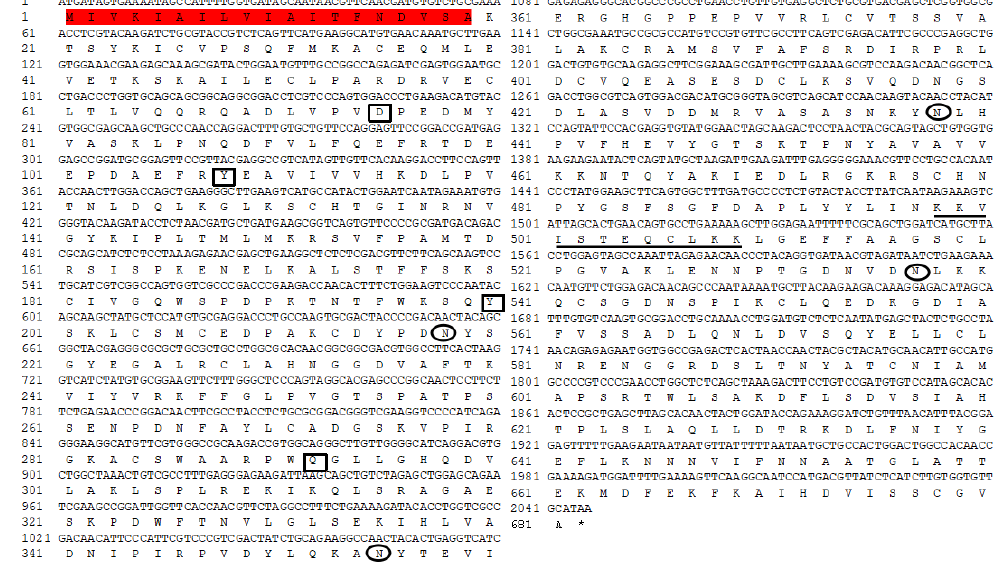
Figure 1. Nucleotide and deduced amino acid sequences of Plutella xylostella transferrin ( PxTrf ). Signal peptide is highlighted in red. Iron binding sites are denoted by black rectangles. Putative glycosylation sites are denoted by black oval. The nuclear localization signal is shown by underlining.